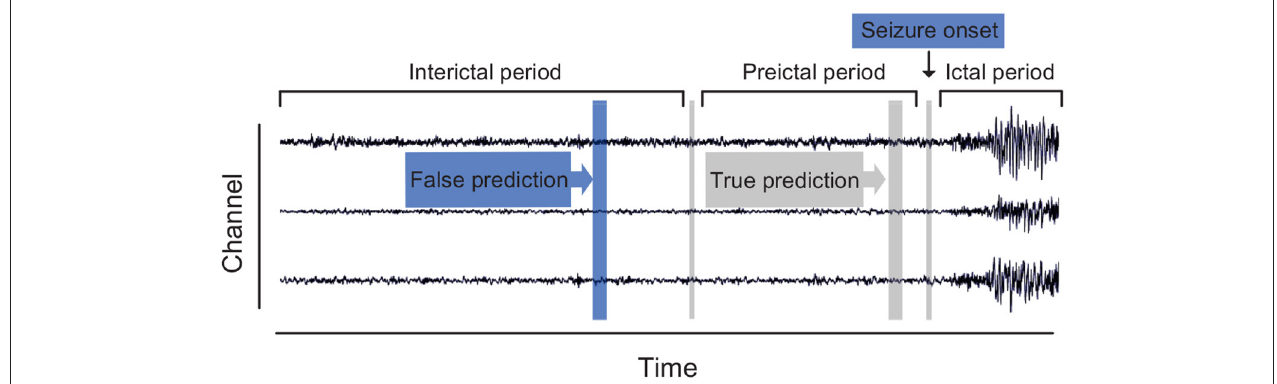
FIGURE 1 | Definition of three brain states in continuous epileptic EEG recordings.